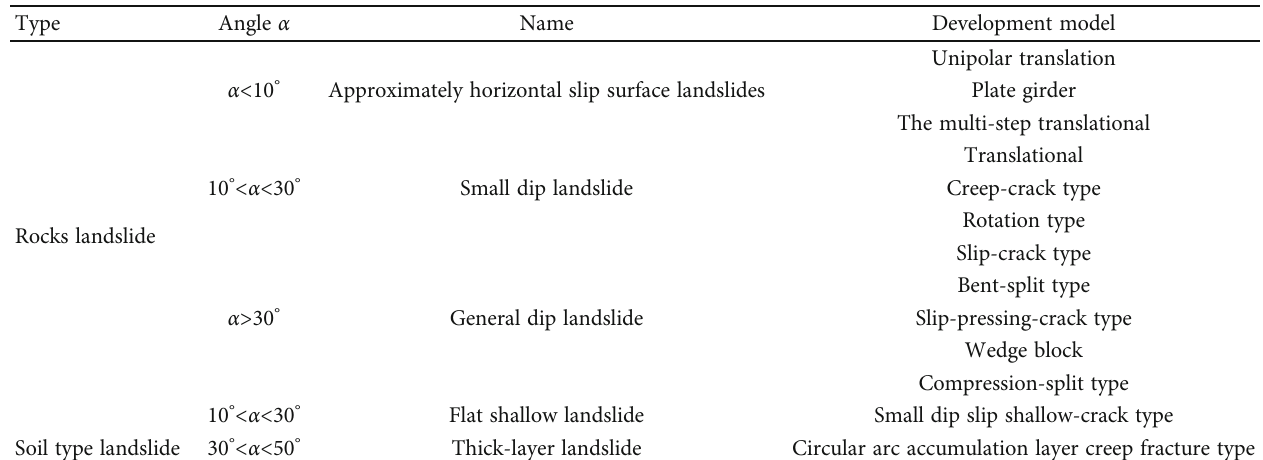
Figure 21: Electrical property anomaly and displacement of the surface monitoring station location. Table 2: The landslide classi fi cation table (cite from